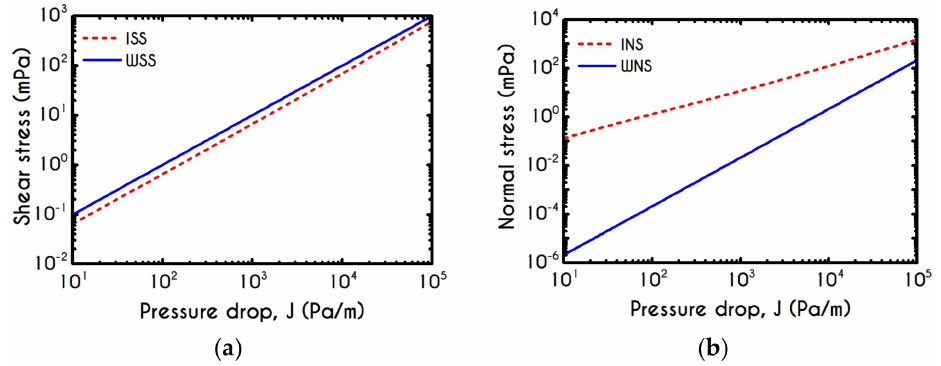
Figure 20. Prediction of ( a ) shear (ISS & WSS) and ( b ) normal (INS & WNS) interfacial and wall viscoelastic stresses as a function of the pressure gradient J for R = 20 µ m and H c = 0.45.